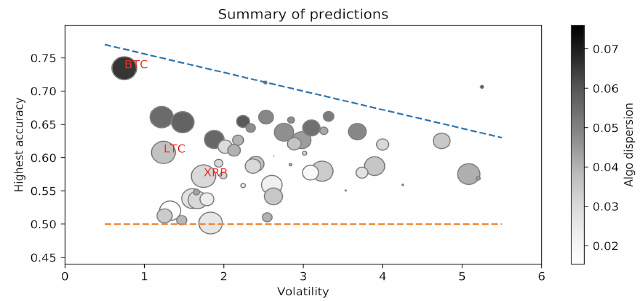
Figure 14: Summary of rolling prediction results (predicting 30-day returns)